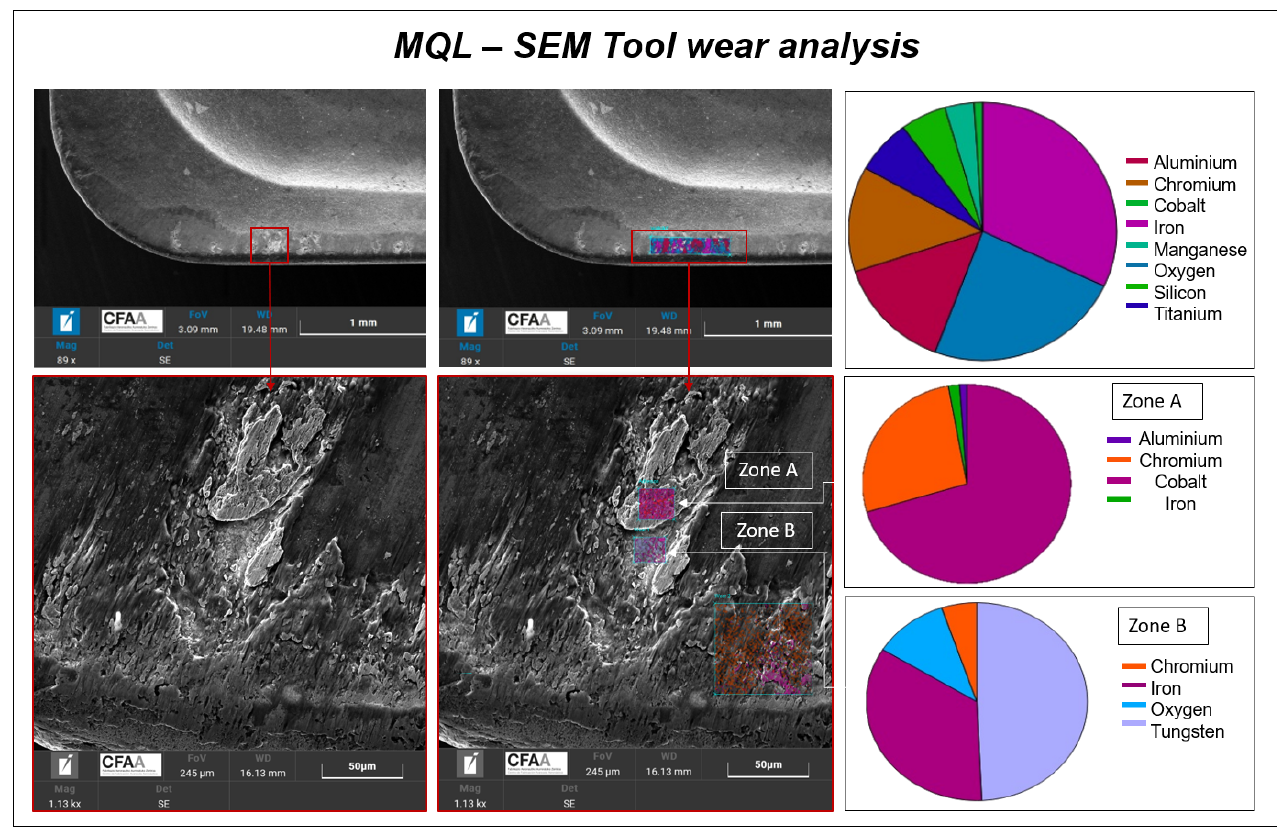
Figure 4. MQL tool wear material analysis.